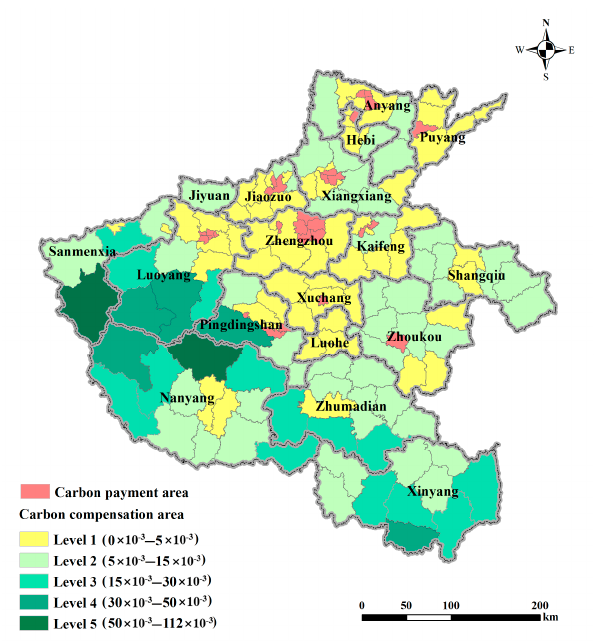
Figure 4. Carbon compensation priority sequence at the county scale.